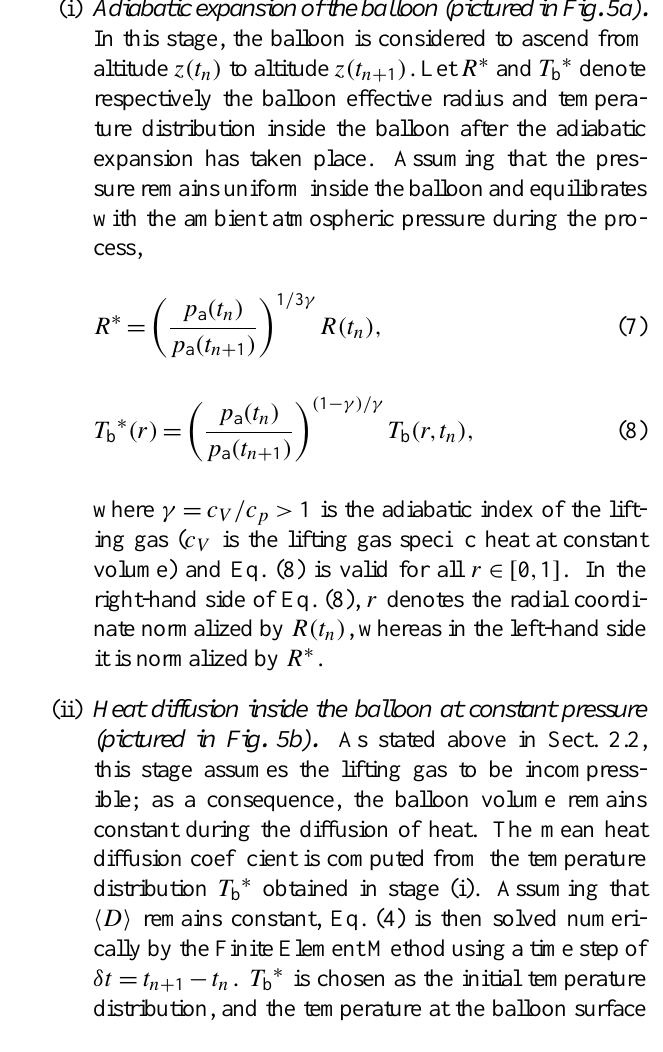
Fig. 3. Derivation of a reference drag curve for sounding balloons. (—) Experimental drag curves derived from the ten LUAMI bal- loon flights; (—) same but with adjusted values for R(z = 0 ) and m tot ; (—) fit to the ten experimental drag curves using a second- order polynomial (Eq. 6). The curves of Achenbach (1972) (dashed) and Son et al. (2010) (symbols) for a perfect sphere are shown for comparison (see Fig.